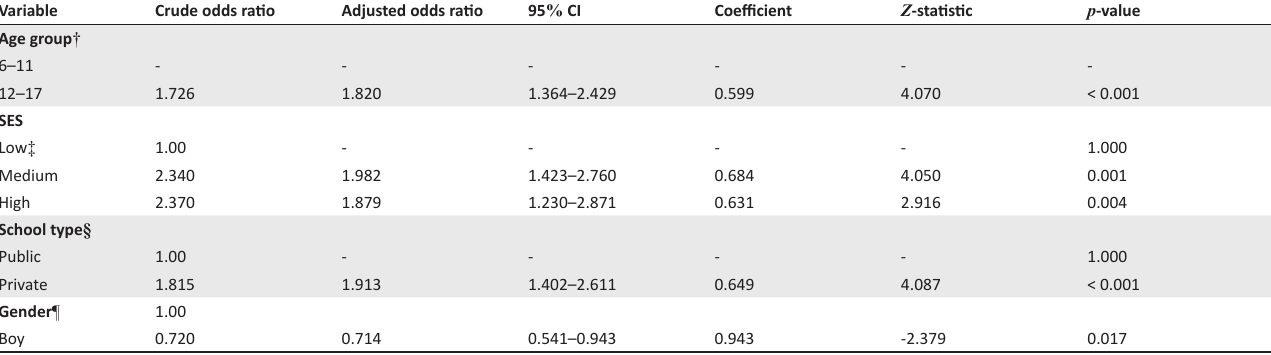
TABLE 6: Logistic regression analysis of the relationship between age group, socio-economic status, school type, gender and prevalence of refractive error. Variable